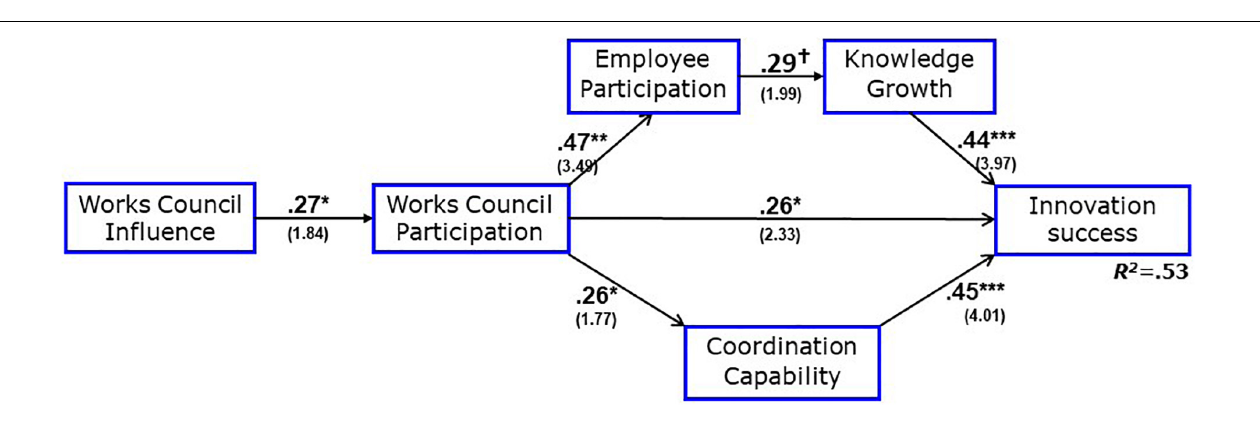
FIGURE 4 | Enlarged model of participation and innovation success. Note see Figure 2 .